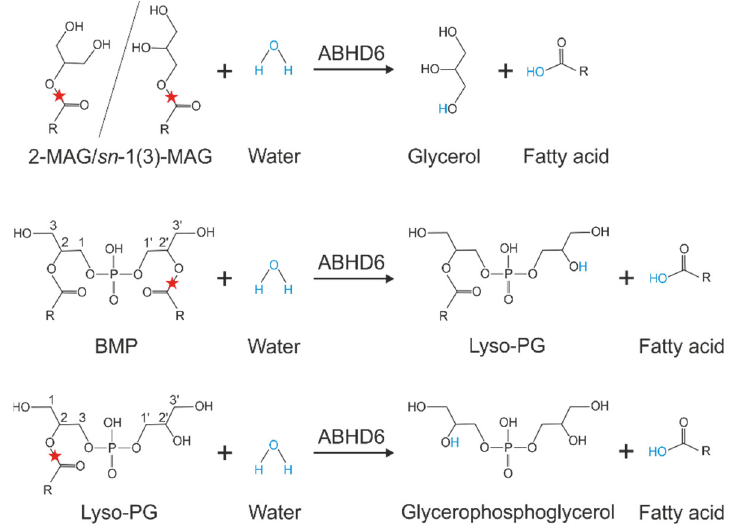
Figure 4. Substrate specificity of ABHD6: ABHD6 is capable of hydrolyzing sn-2 and sn-1(3) Figure monoacylglycerols (MAGs) releasing glycerol and a fatty acid, the phospholipid bis(monoacylglycerol)phosphate (BMP) generating lyso-phosphatidylglycerol (LPG) and a fatty acid, and LPG releasing a fatty acid and glycerophosphoglycerol. The red star indicates the cleavage site and R indicates an acyl chain.